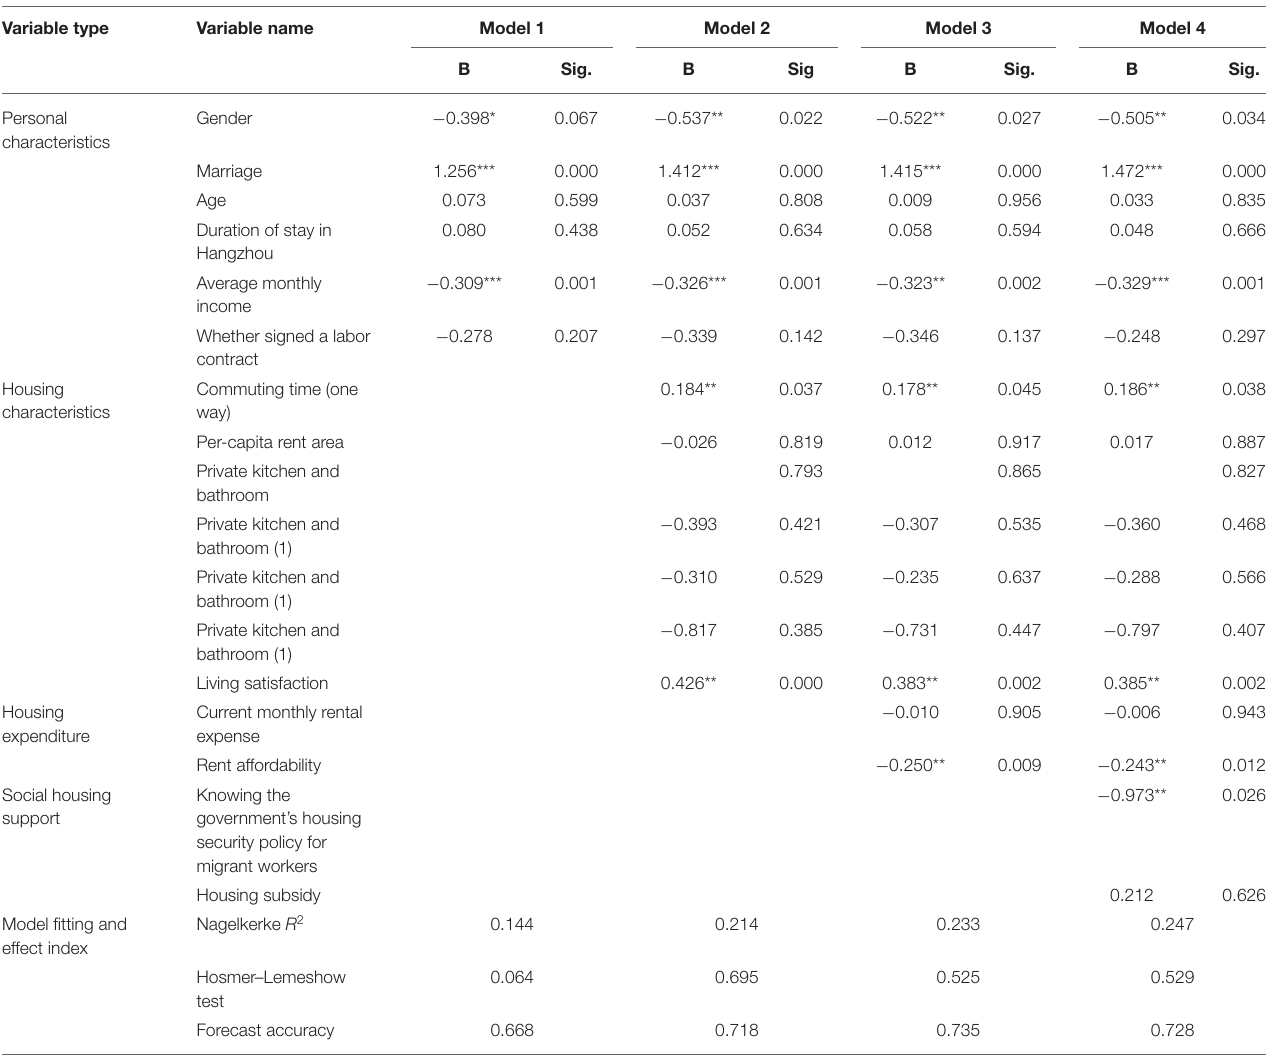
TABLE 6 | Ordered logit regression results for factors influencing migrant workers’